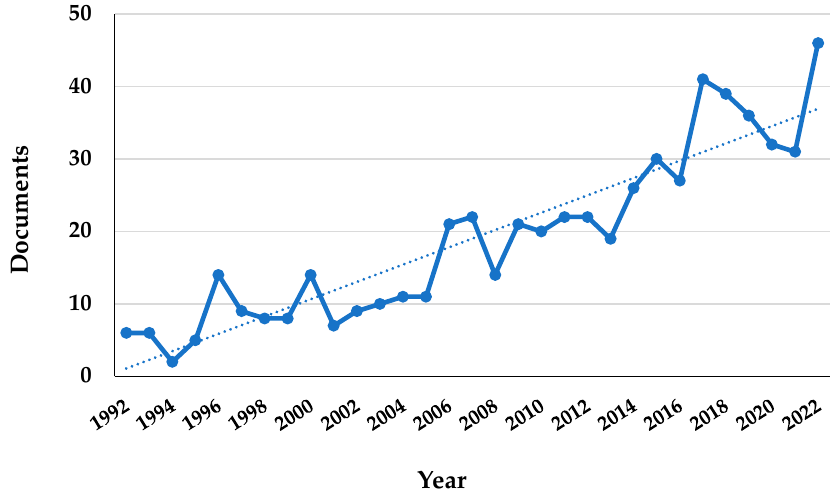
Figure 2. Increasing number of articles on H. sphondylium published from 1992 to 2022 (data retrieved from Scopus ® database). The dashed line indicates the growing trend of the published